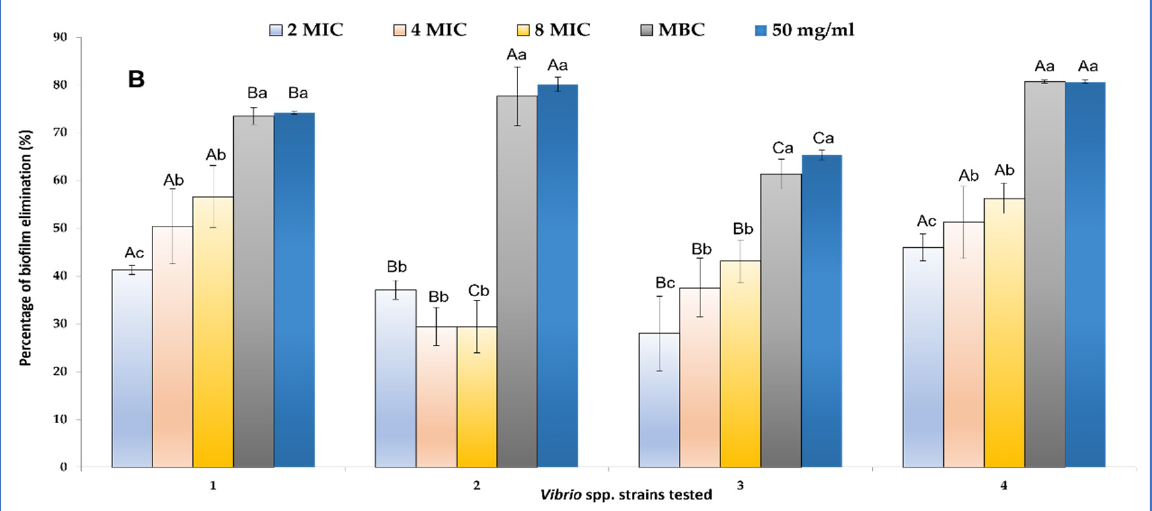
Figure 2. Effects of different concentrations of C. carvi EO on biofilm formation ( A ) and eradication ( B ) expressed as percentages of inhibition evaluated by the XTT technique: V. alginolyticus ATCC 33787 ( 1 , MIC value= 0.022 mg/mL) , V. parahaemolyticus ATCC 17802 ( 2 , MIC value = 0.022 mg/mL), V. vulnificus ATCC 27962 ( 3 , MIC value= 0.022 mg/mL) , and V. cholerae ATCC 9459 ( 4 ) . Errors bars represent standard deviation. Values are the average of at least three independent determinations. Means followed by the same letters are not significantly different at p < 0.05 based on Duncan’s multiple range test. Small letters are used to compare different concentrations within the same strain, and capital letters are used to compare means between the same concentrations between strains. Table 4. Effect of caraway essential oil and its major compound (carvone) on the swarming activity of P. aeruginosa PAO1 strain expressed as mean diameter of growth on LB-0.5% agar